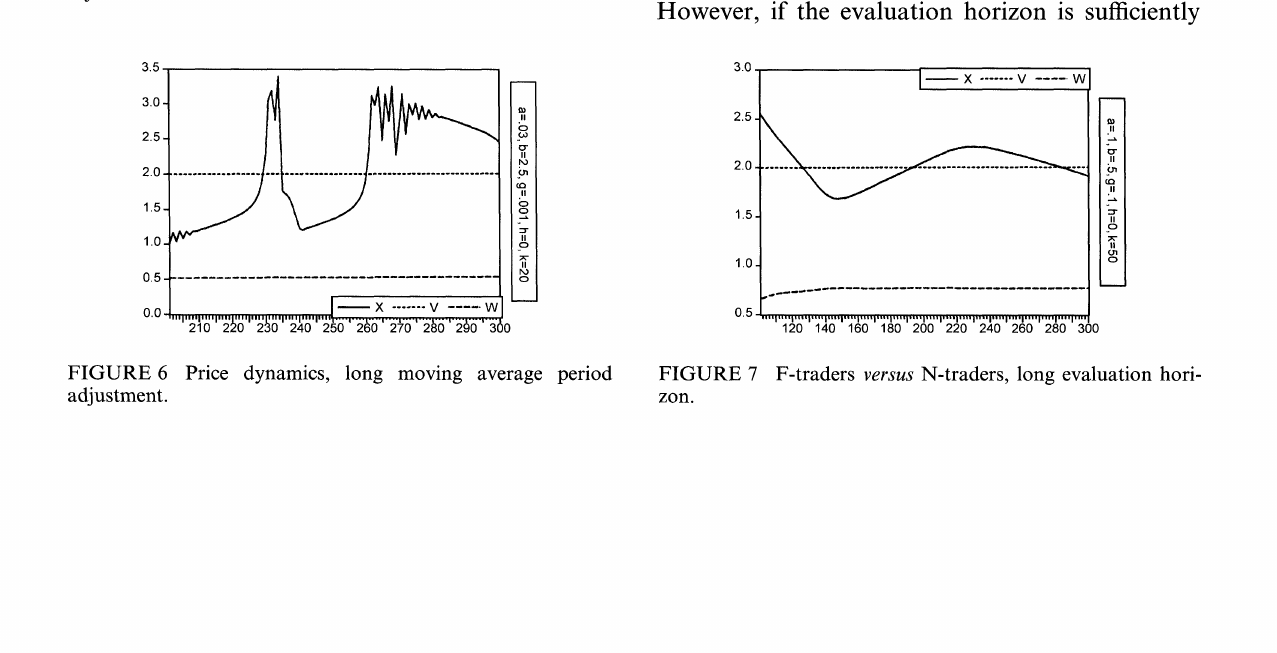
FIGURE 5 Price dynamics, short moving average period adjustment.